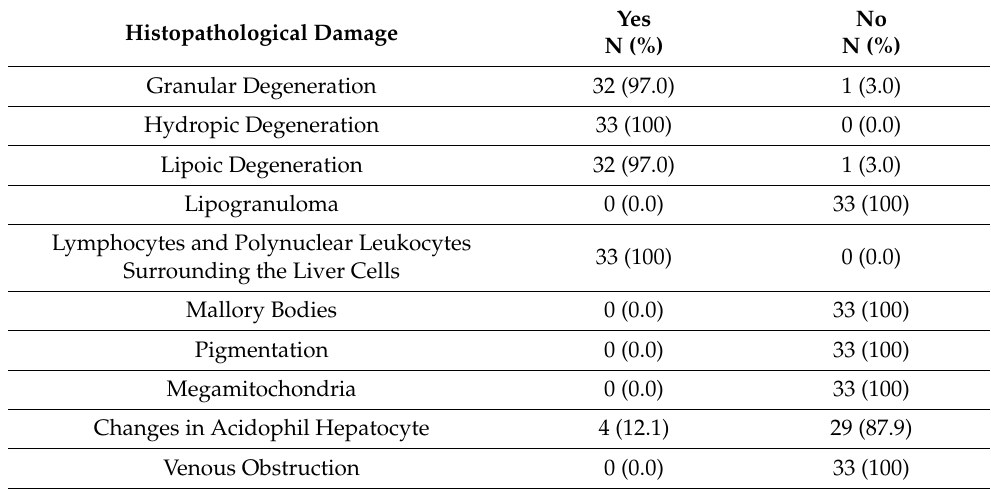
Table 3. Histopathological damage among chronic hepatitis patients who were exposed to dioxin.